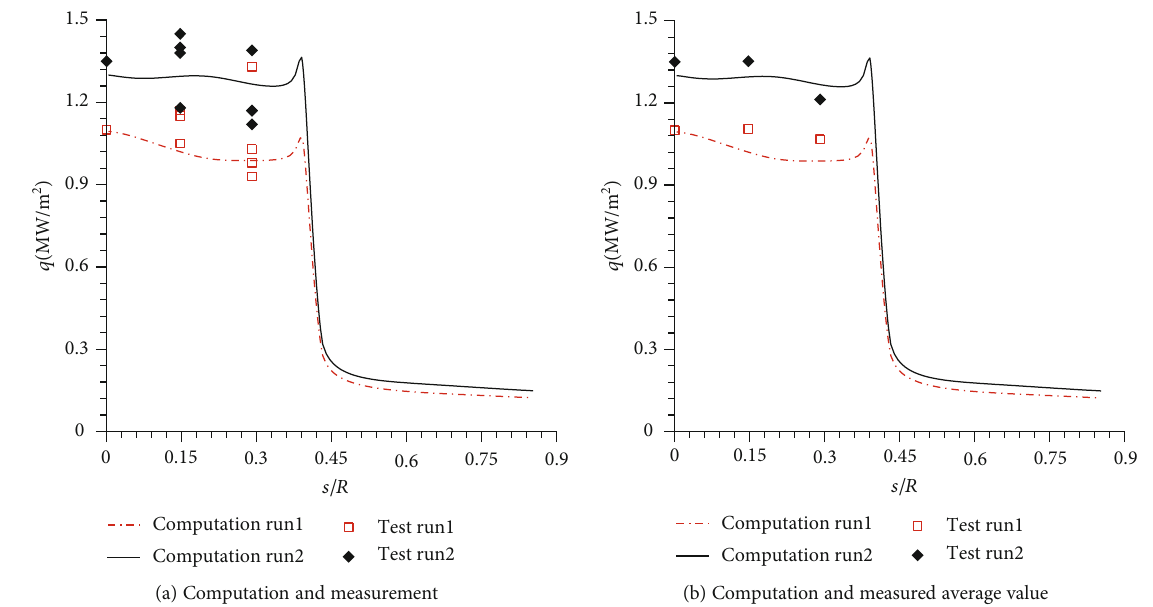
Figure 5: Heat fl ux along the surface of the blunt model. Table 2: Flight and ground conditions under similar enthalpy and calibrated heat fl